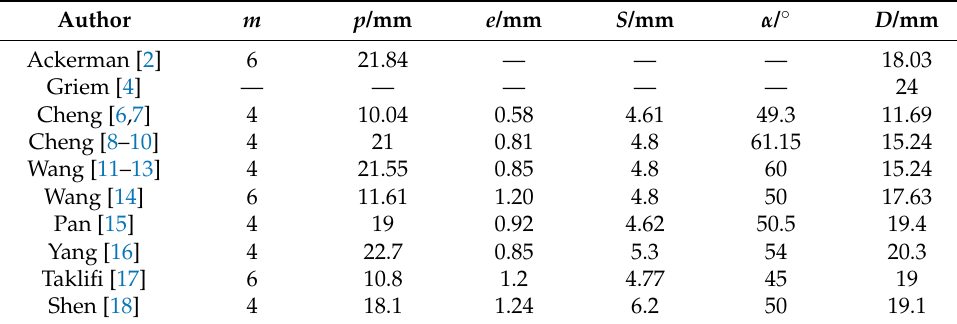
Table 1. Summary of the rib structures of IRTs in the open